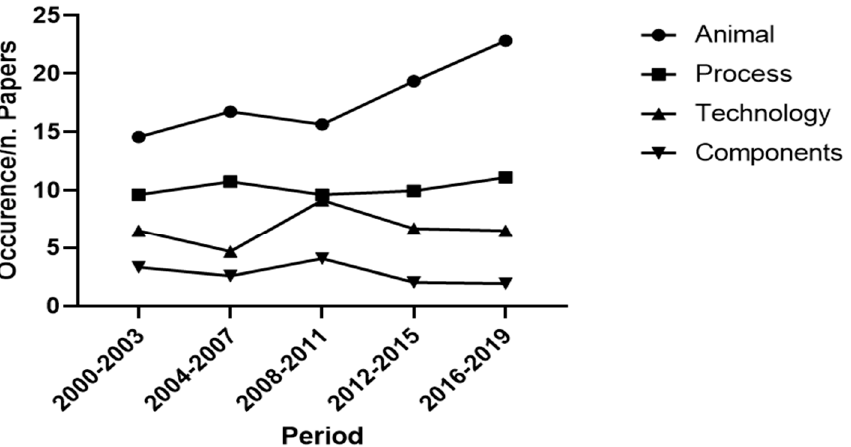
Figure 3. Papers: course of the clusters over the last two decades. The weight of the cluster for each four-year period was calculated as the ratio between the occurrence of words belonging to a cluster and the total amount of papers. Table 3. Conceptual clusters derived from the analysis of papers. The main words of each cluster, along with their frequency, is reported in the second column. Words marked with an asterisk have undergone the stemming process, which consists of including in a single lemma all variant forms of the same word (i.e., images and imaging, or udder and teats). In most cases stemming was applied to words with common root (e.g., lactation and lactating); in some cases, stemming was applied to words with the same meaning (e.g., udder and teat).